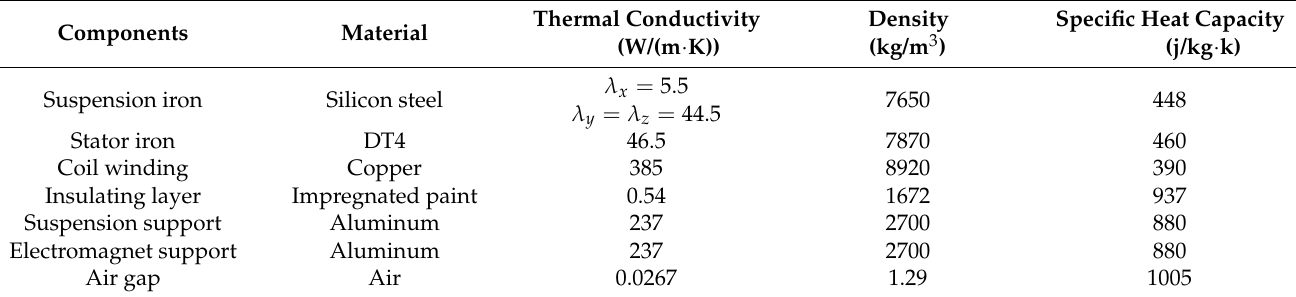
Table 1. Thermal parameters of magnetic bearing